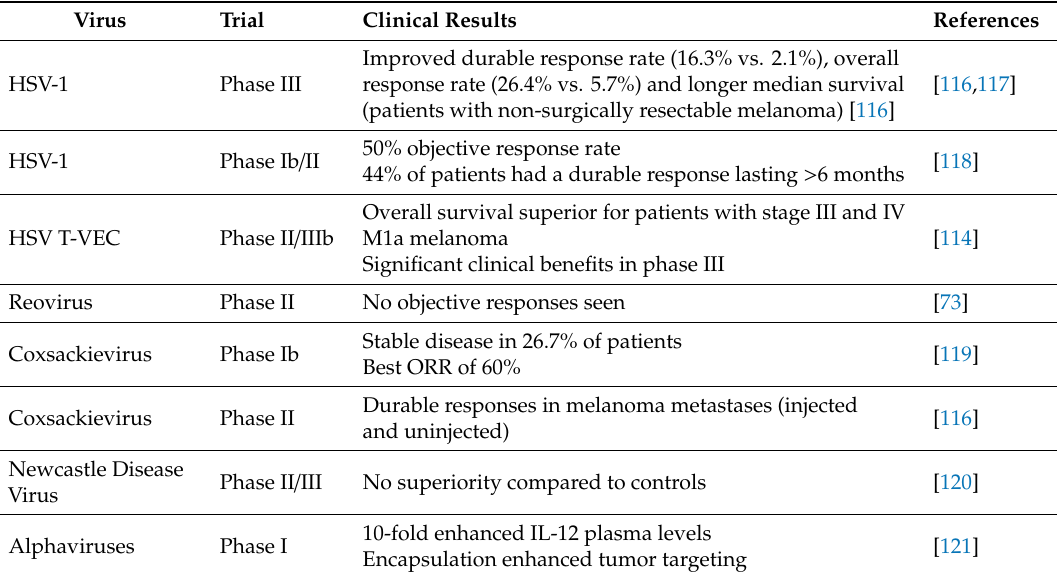
Table 2. Clinical trials of melanoma treatment using oncolytic